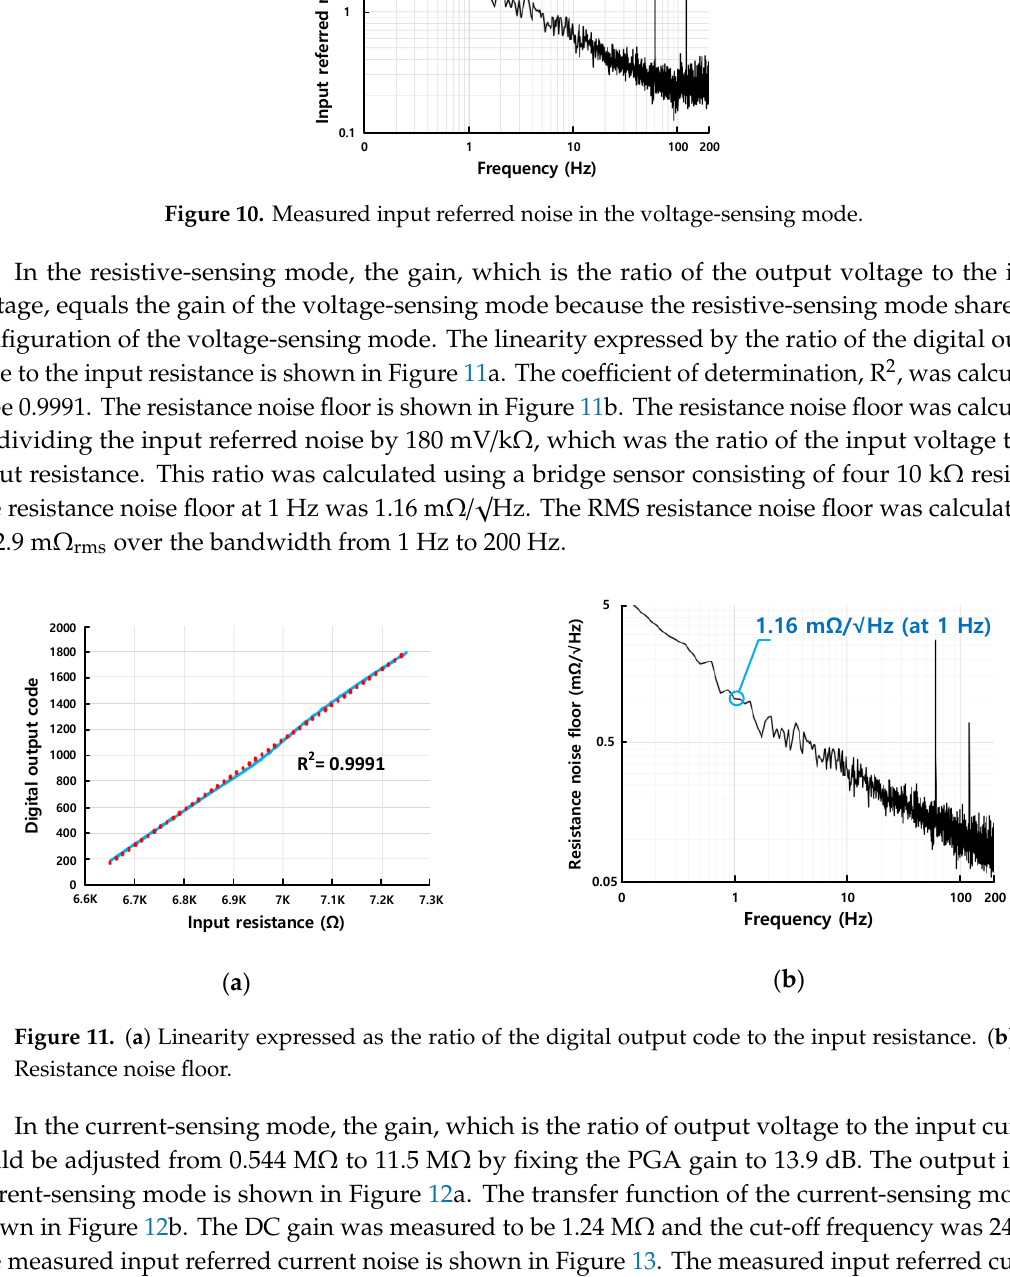
Figure 12. ( a ) Output in the current-sensing mode. ( b ) Transfer function of the current-sensing mode.